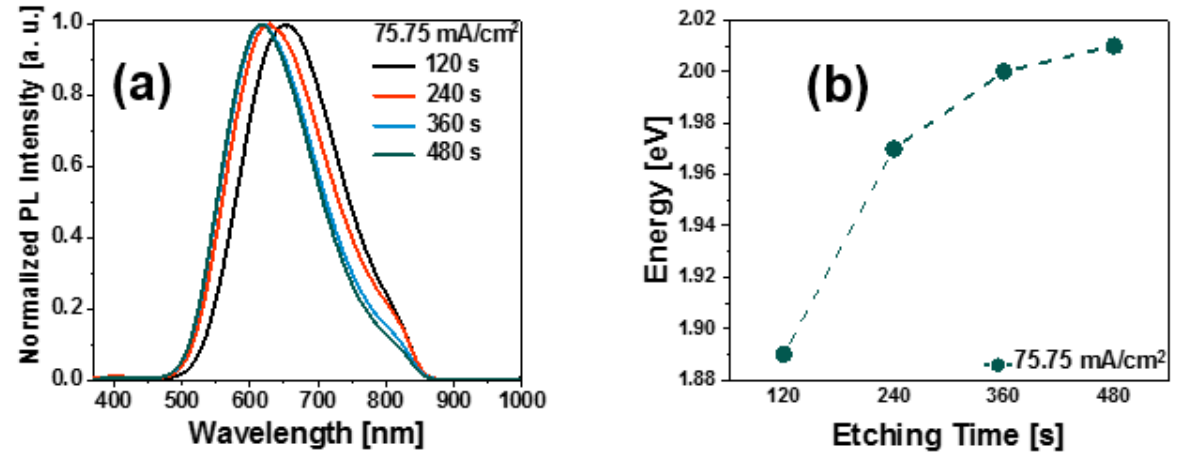
Figure 4. ( a ) Normalized PL spectra of the PSi layers varying the etching time for a constant anodizing current, ( b ) The PL shift peaks of the PSi layers. Table 2. Energy values [eV] of the band gap of PSi layers.